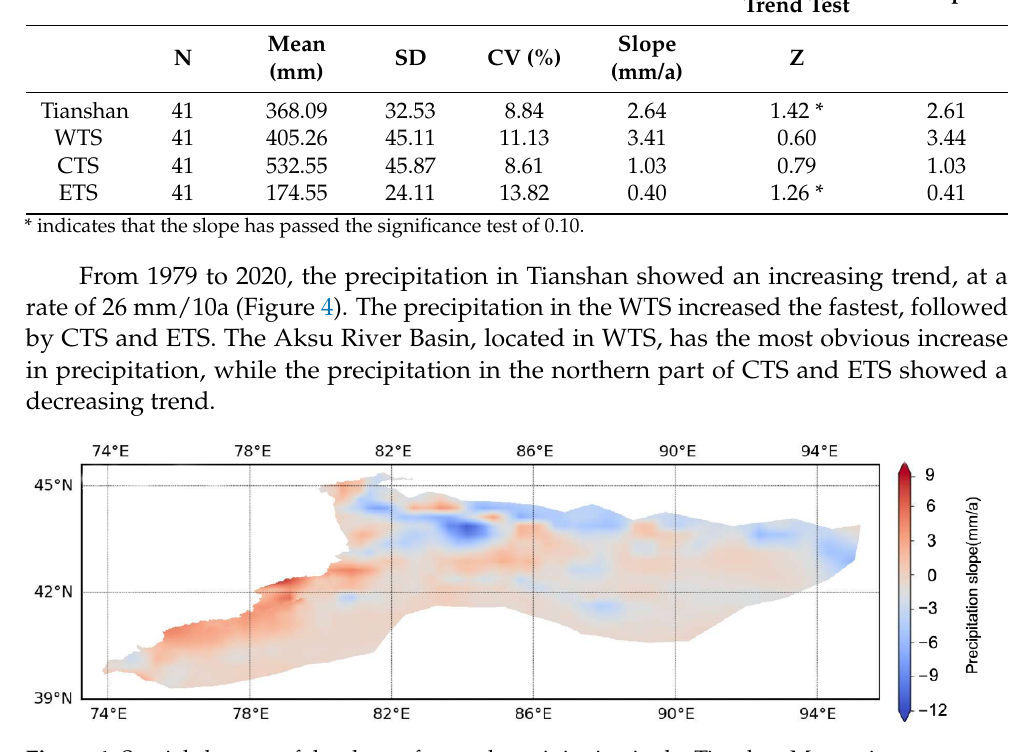
Figure 4. Spatial changes of the slope of annual precipitation in the Tianshan Mountains.